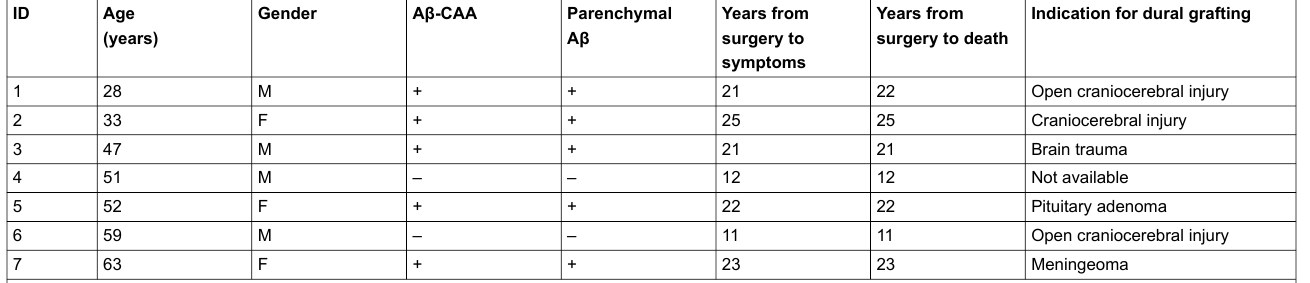
Table 1: Clinical details of patients suffering from iatrogenic CJD and indications for dural grafting. ID Age